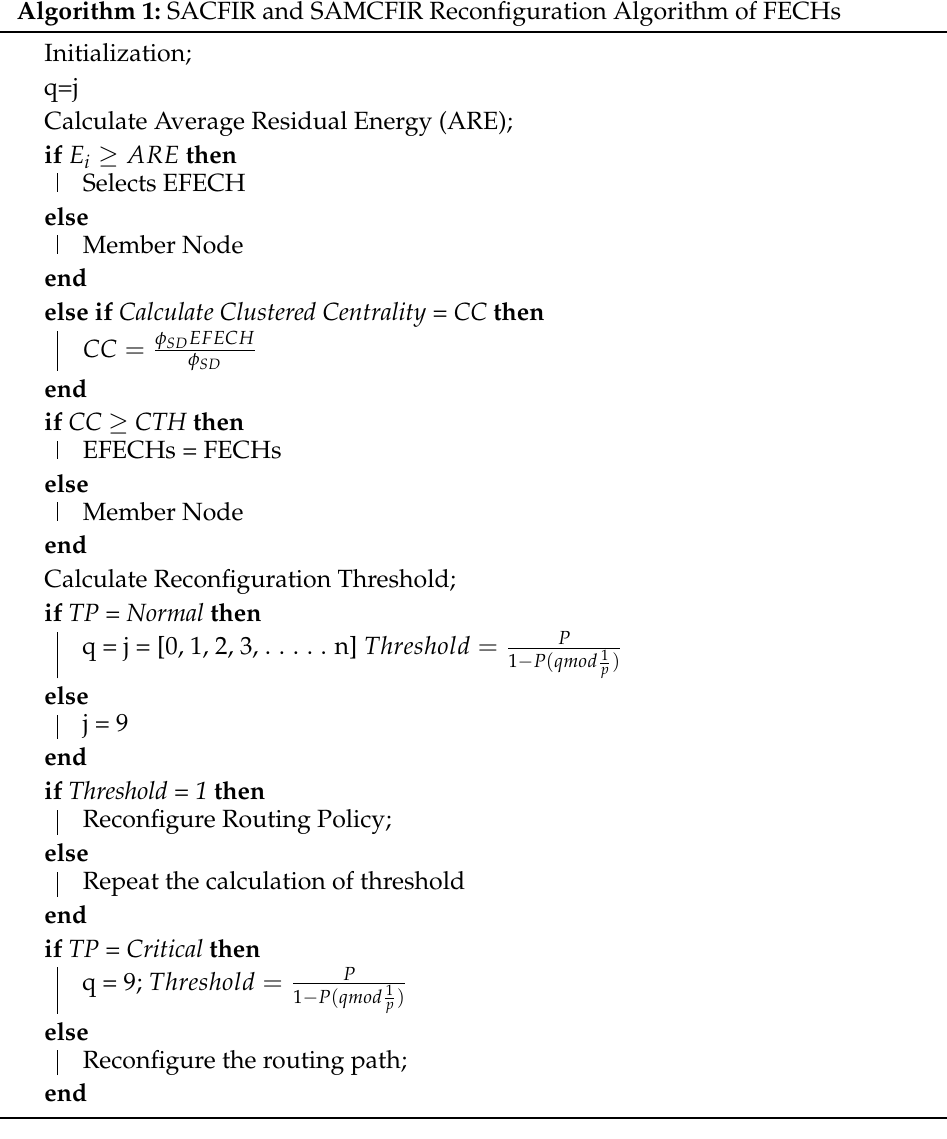
Algorithm 1: SACFIR and SAMCFIR Reconfiguration Algorithm of